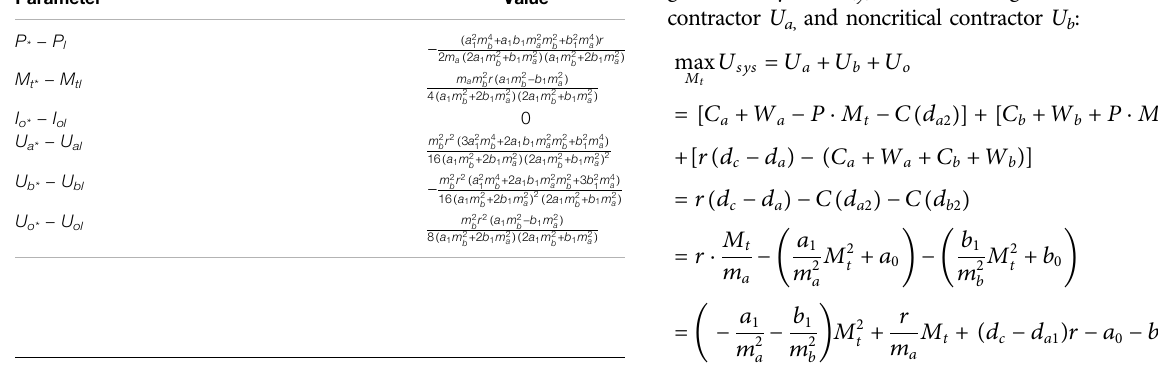
TABLE 4 | Comparison of equilibrium values in Scenarios I and II. Parameter Value